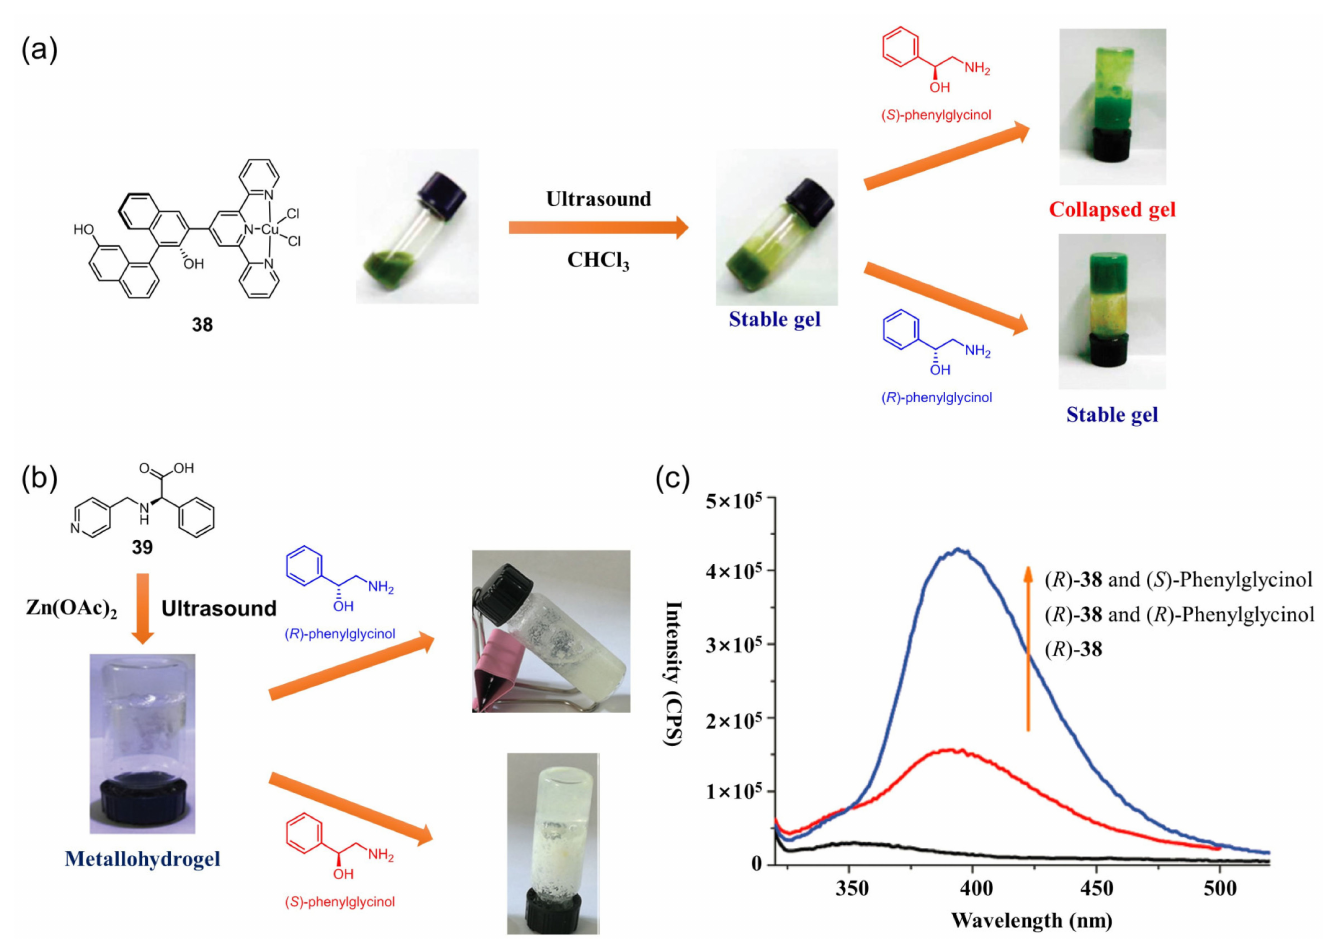
Figure 16. ( a ) Photographs of the enantioselective responses of the gel of ( R )- 38 toward ( R )- phenylglycinol and ( S )-phenylglycinol. Reprinted with permission from Ref. [74]. Copyright (2010), American Chemical Society. ( b ) Enantioselective responses of the metallohydrogel toward ( R )-phenylglycinol and ( S )-phenylglycinol. ( c ) Fluorescence spectra of ( R )- 38 (5.0 × 10 − 7 M) in CH 2 Cl 2 /nhexane (2:3) in the presence of ( R )- and ( S )-phenylglycinol (5.0 × 10 − 4 M) ( λ exc = 289 nm). Reprinted with permission from Ref. [75]. Copyright (2020), Royal Society of